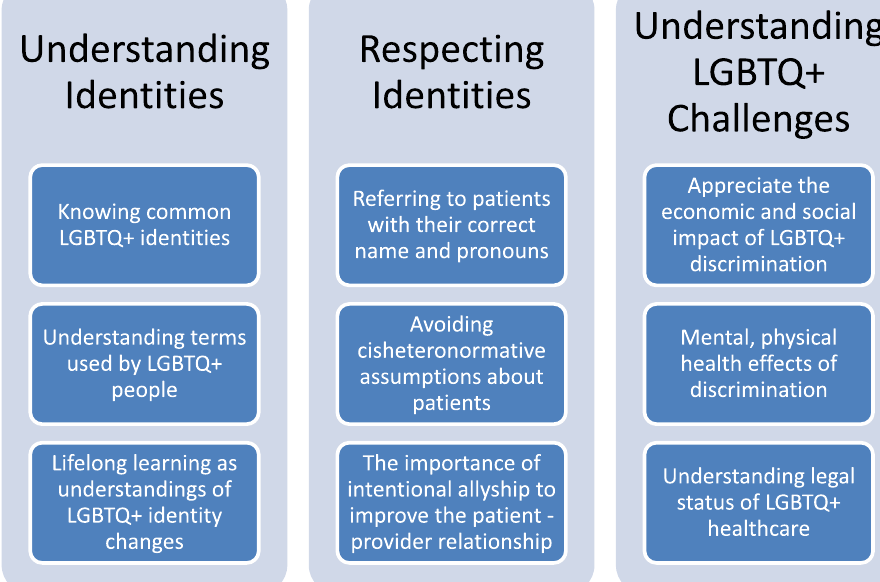
Fig. 1 Core LGBTQ + Compe- tencies for Allied